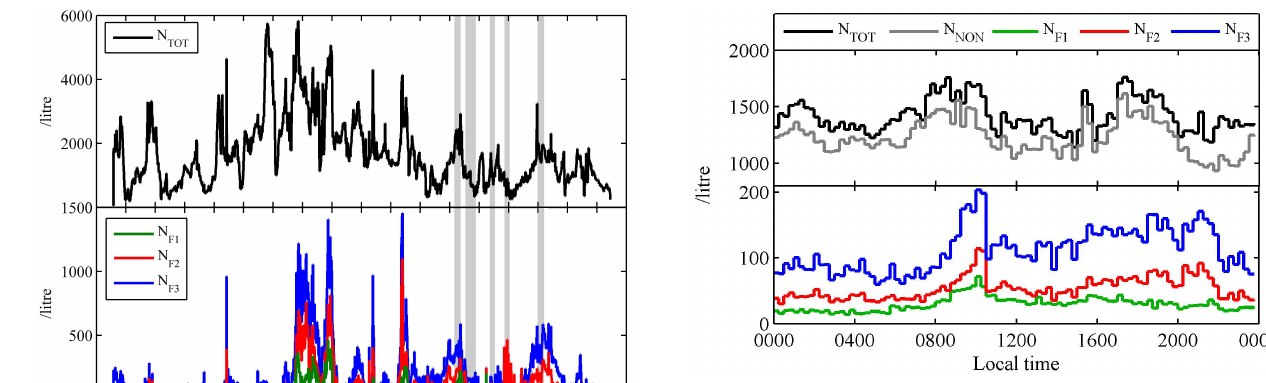
and peak at ∼ 20:00.